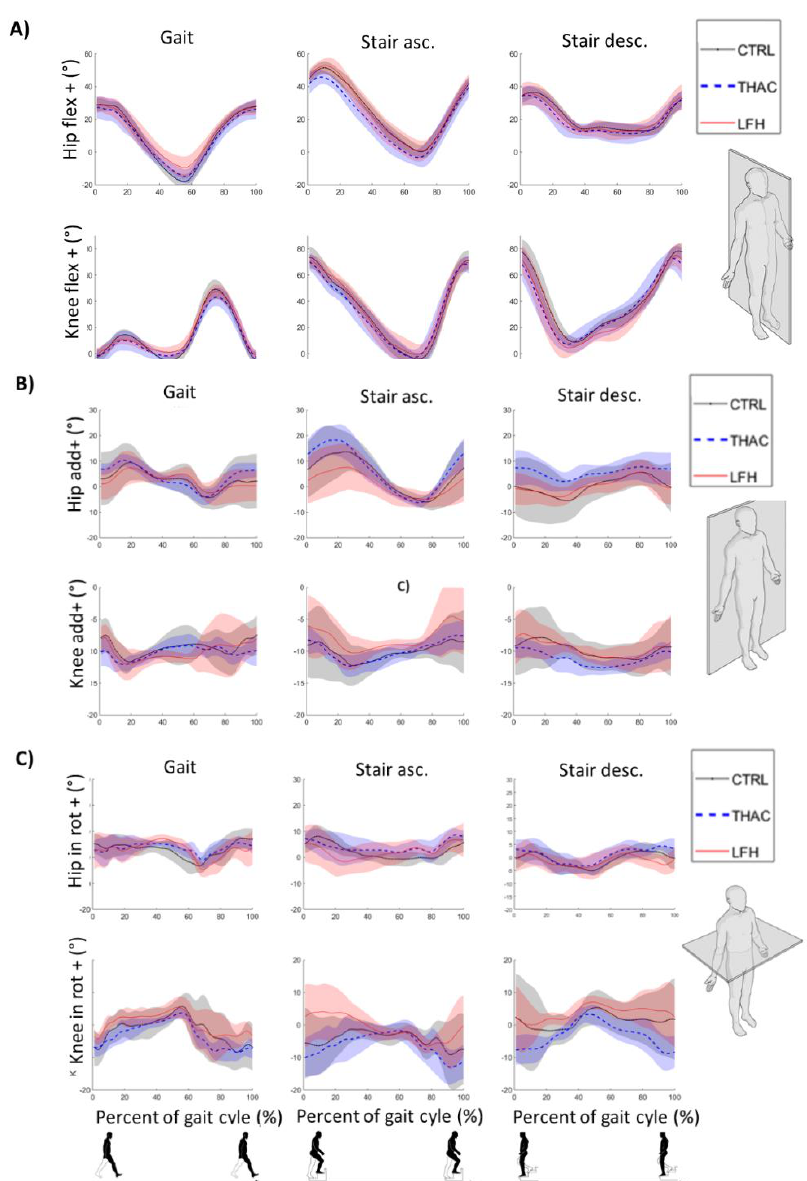
Figure 2. Angle curves in the hip and knee joints during gait and stair walking for sagittal plane motion ( A ), frontal plane motion ( B ) and transverse plane motion ( C ). The average angle curves are plotted with standard deviations as a shaded area for the non-dominant side of healthy controls (CTRL) and the operated side of the group with a conventional prosthesis (THAC) or large femoral head (LFH) design.